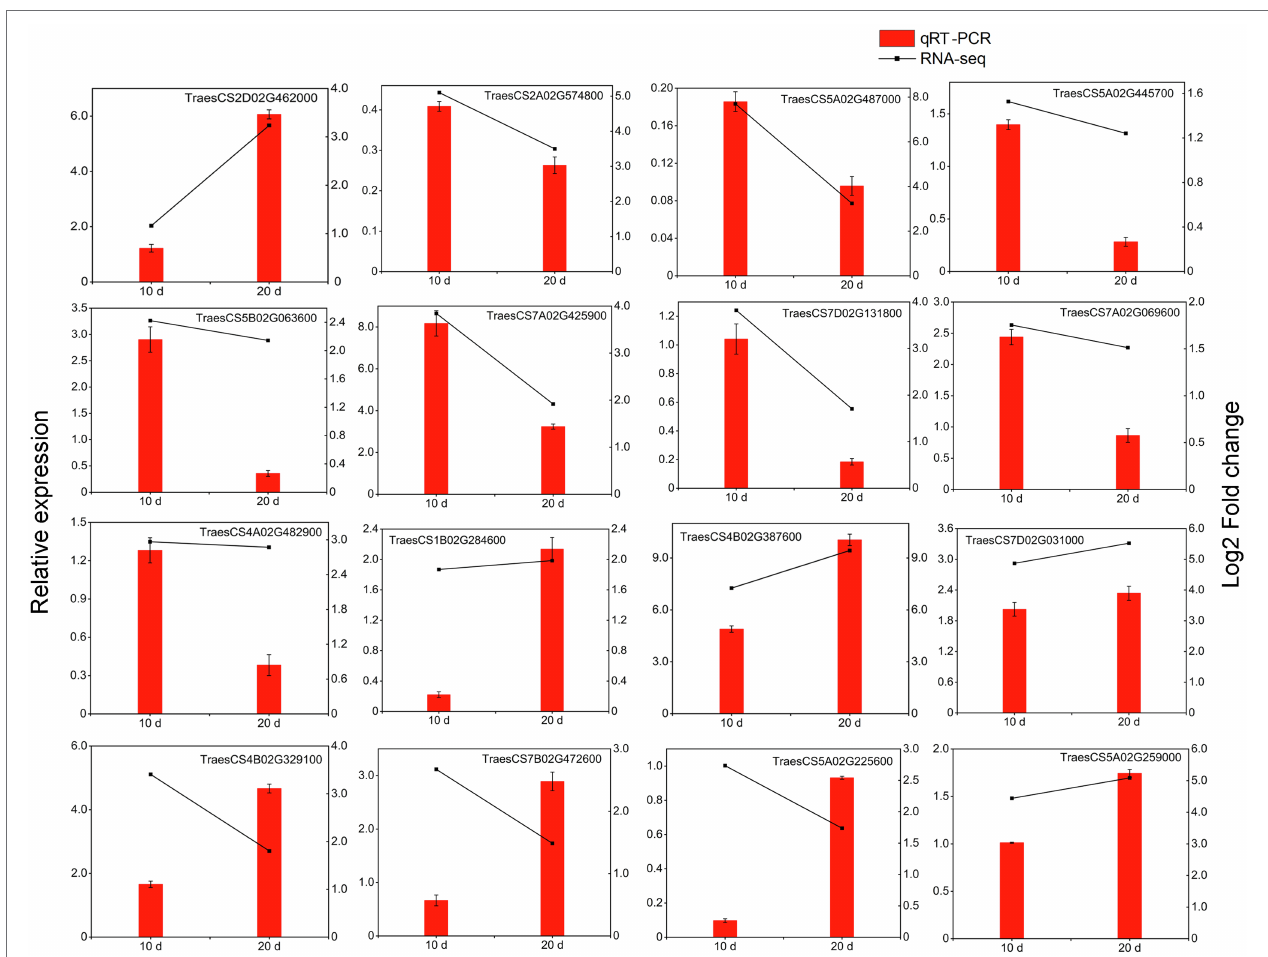
FIGURE 9 | qRT-PCR analysis of selected DEGs in triticale under the yellow rust infection. Red columns indicate relative expression levels determined by qRT-PCR (left y -axis), and dashed lines represent transcript level changes (log 2 fold change) based on FPKM values determined by RNA-Seq (right y